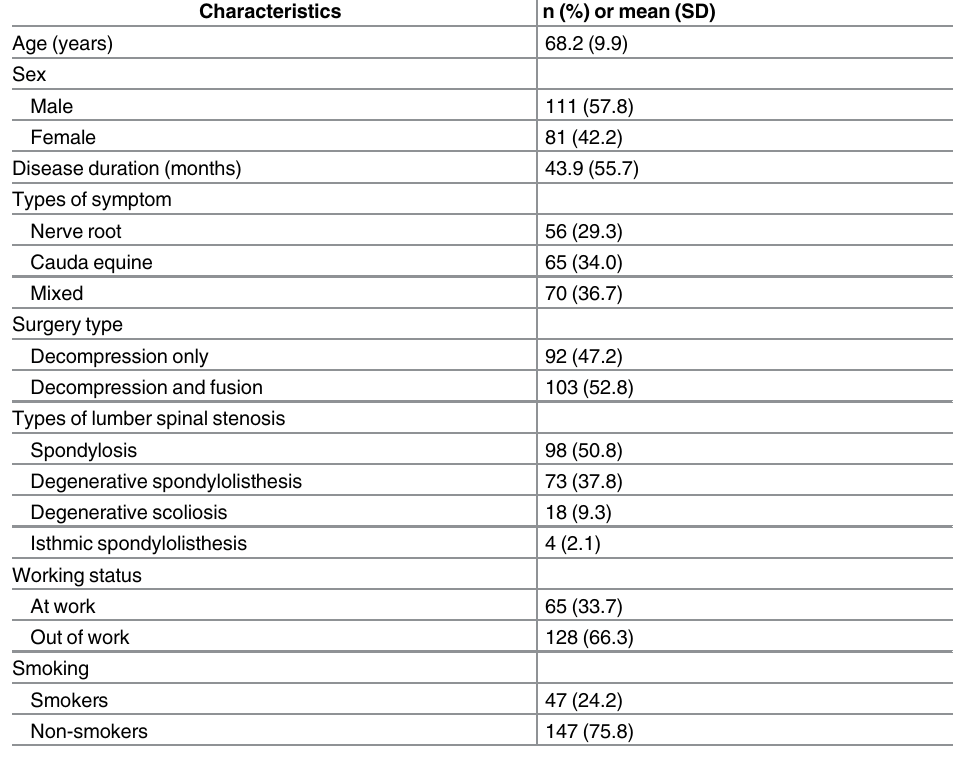
Table 1. Demographic and clinical characteristics of the lumber spinal stenosis patients (n = 195).